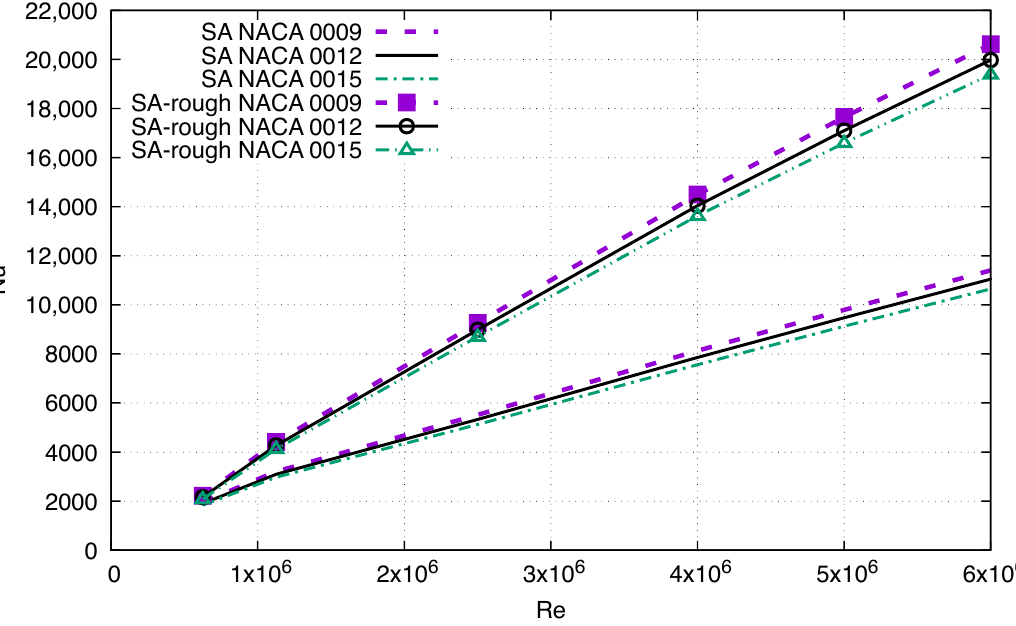
Figure 9. Nu r in the leading edge area as a function of Re : comparison between the CFD results for the NACA 0009, the NACA 0012, and the NACA 0015 at α = 0. Smooth and rough airfoil.